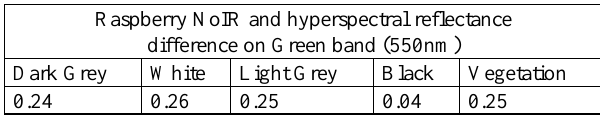
Table 4. Distances between Raspberry reflectance values of green band and Hyperspectral ones. The data are referred to sample pixels of the calibration panels.